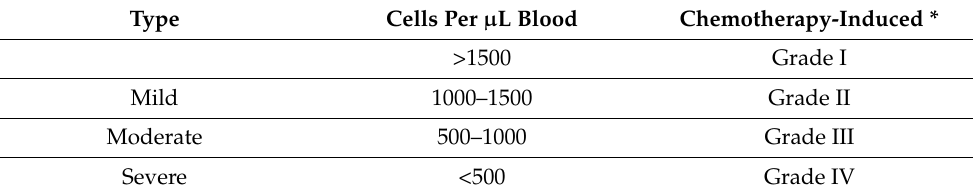
Table 1. Types of neutropenia, modified according to Palmblad et al., the National Institutes of Health, and the National Cancer Institute [14,18]. * The grade of chemotherapy-induced neutropenia is not only evaluated by the concentration of neutrophilic granulocytes, but of all immune cells. Type Cells Per µ L